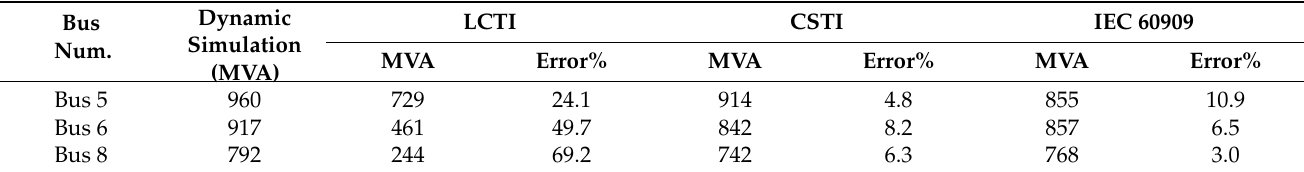
Table 6. Fault level MVA obtained in scenario two.